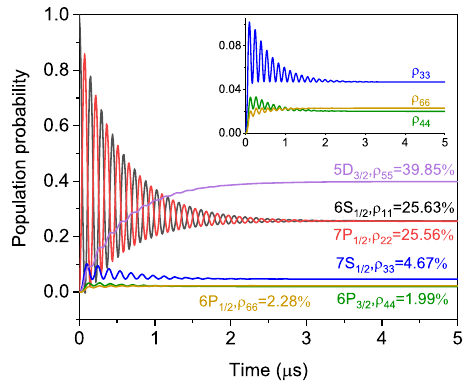
Fig. 5 Numerical results of the population probability of each state ρ ii in Fig. 1a. Here, g = 1.99 × 10 5 s − 1 , Ω = 4.30 × 10 7 s − 1 , and N eff = 5.71 × 10 9